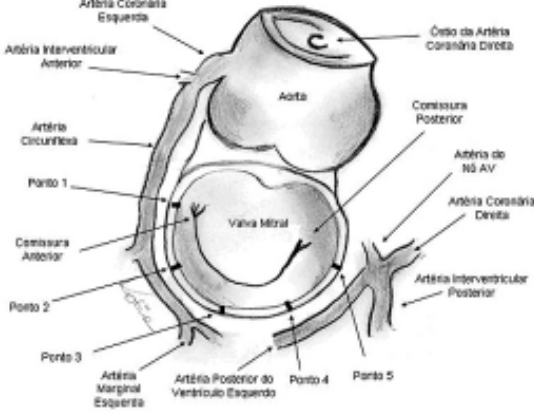
Fig. 1 – Demarcação da porção posterior do ânulo da valva mitral.